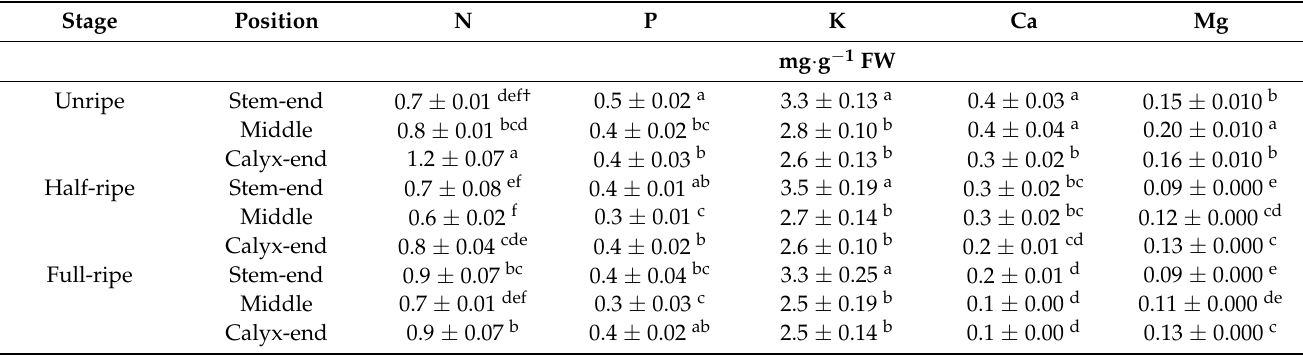
† Different letters within columns indicate significant differences by Duncan’s multiple range test. Table 8. Changes in micronutrients of “Tainung No. 2” Red papaya ( Carica papaya ) pulp at 3 parts across ripening stages (unripe, half-ripe, and full-ripe).